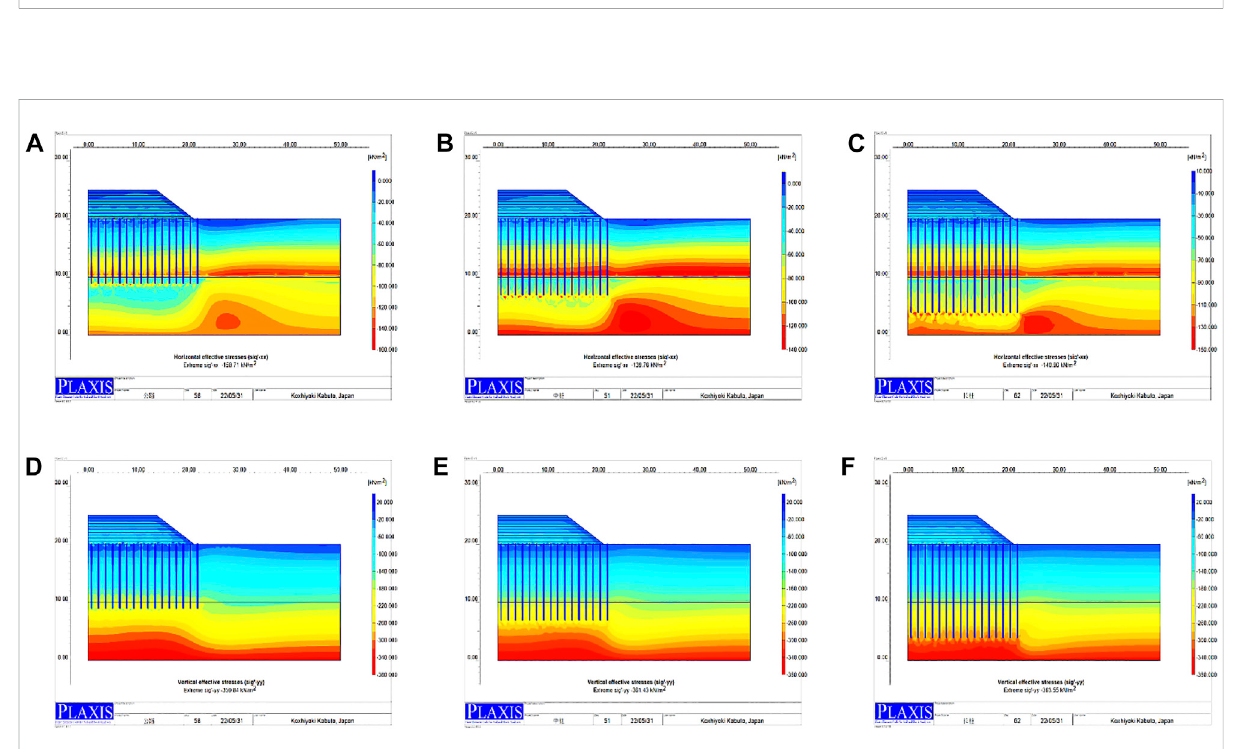
settlement and horizontal displacement of the embankment at the pile top induced by the cushion thickness changes along the embankment width. As demonstrated in Figure 7 the gravel cushion exerted no impact on the structural deformation due to the large embankment height and equivalent load. Moreover, the changes in the cushion